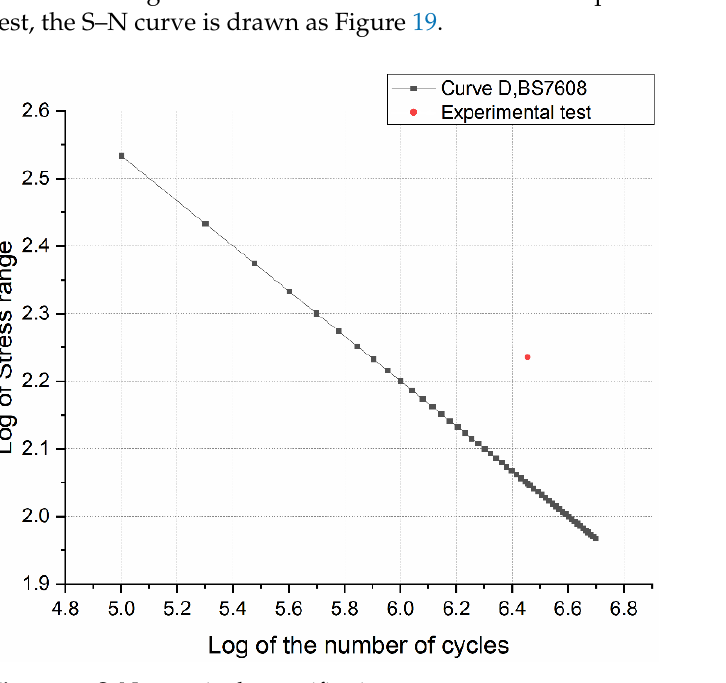
Figure 19. S–N curve in the specification.